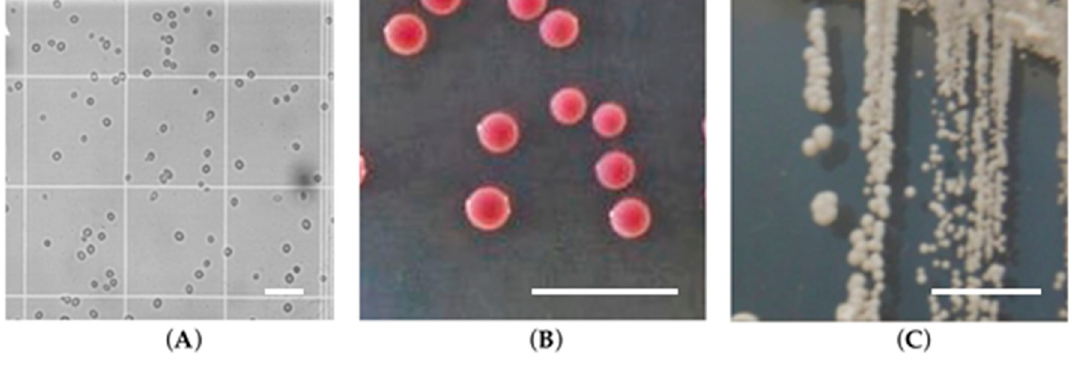
Figure 1. Candida glabrata cells: ( A ) microscopy structure; ( B ) on CHROMagar TM Candida ; ( C ) on Sabouraud dextrose agar (adapted from [4]). The scale corresponds to 50 µm with a magnification of 200×.